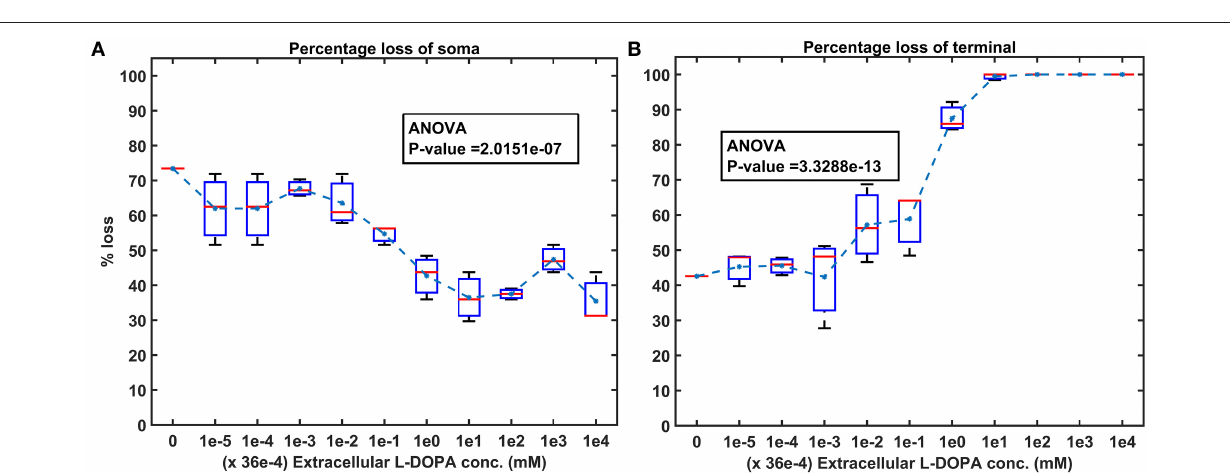
concentrations of extracellular L-DOPA, loss of SNc somas was lower compared to lower concentrations of extracellular L-DOPA to higher extracellular DA concentrations. The extracellular L- DOPA concentration of 36 x 10 − 5 mM was considered as basal extracellular L-DOPA concentrations in the proposed LIT